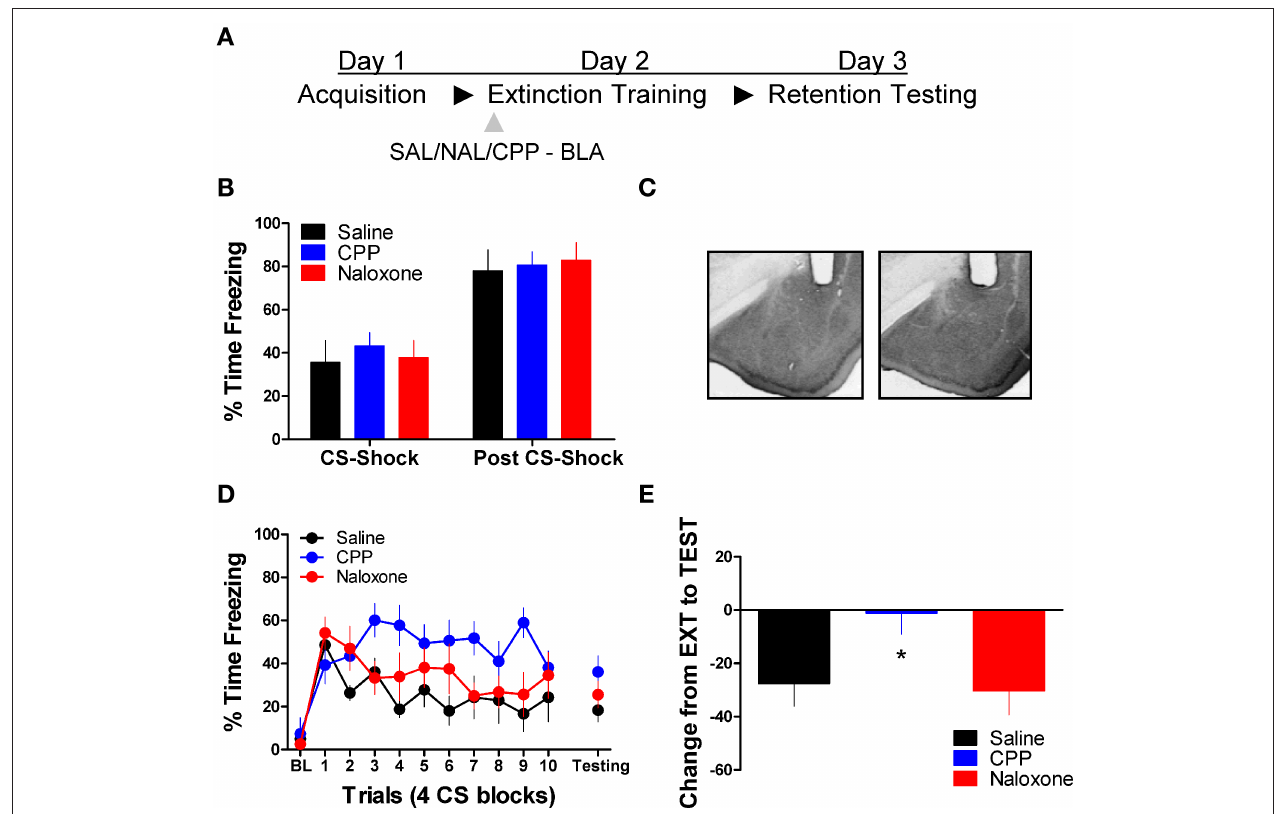
Figure 2 | Blockade of NMDA but not opioid receptors in the amygdala disrupts memory for fear extinction. (A) A schematic showing the behavior procedures in this experiment. (B) Freezing behavior during the fear acquisition session in all three groups of rats. (C) Representative cannulae placements in the